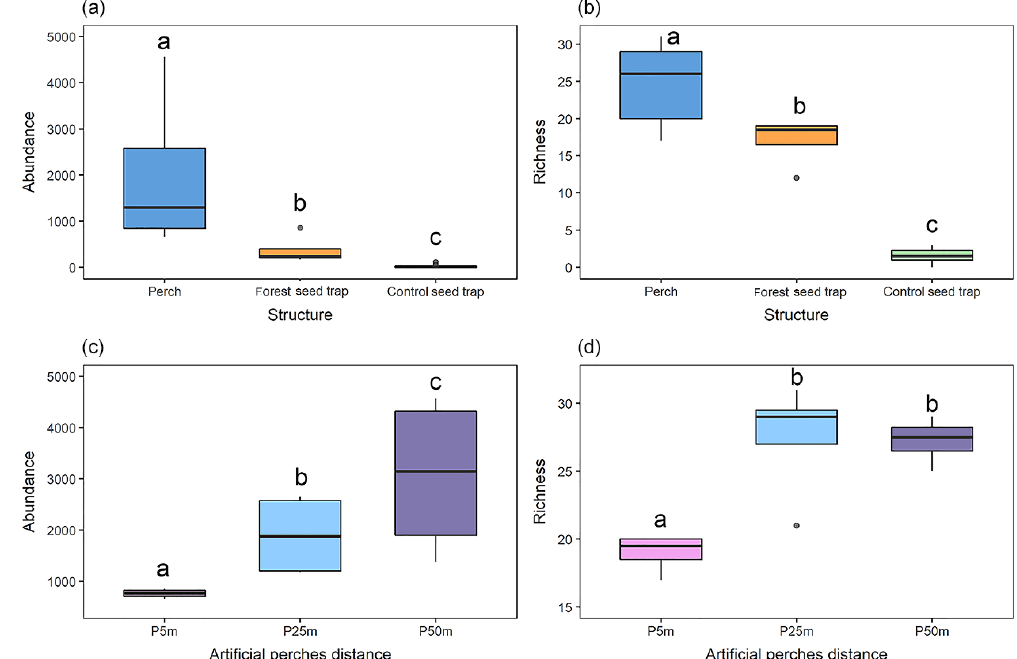
Figure 3. Graphical representation of the variation in (a) the abundance of seed rain under the different structures; (b) seed rain richness under the different structures; (c) the abundance of seed rain under artificial perches at 5, 25, and 50m from the edge of the forest fragment; and (d) richness of seed rain under artificial perches at 5, 25, and 50m from the edge of the forest fragment. Significant differences between groups at p < 0.05 are denoted by different letters.